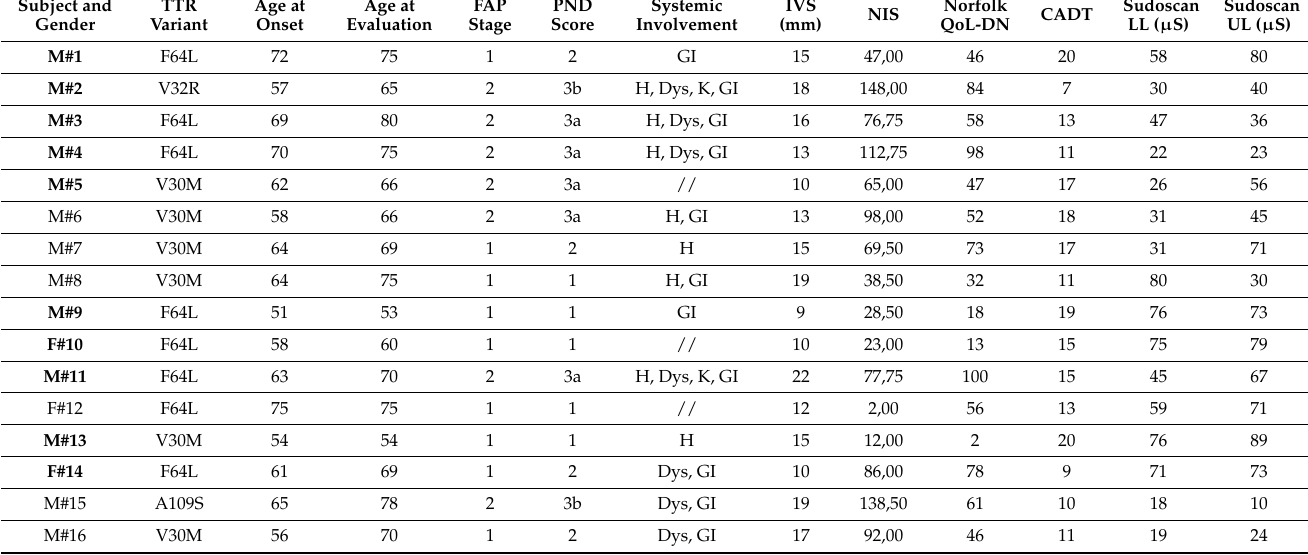
Table 1. Detailed demographic and clinical data of ATTRv group.